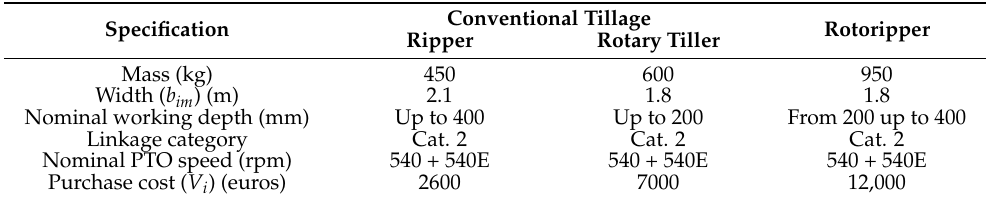
Table 1. Implement specifications claimed by the manufacturers. The purchase cost was obtained from the purchase bill for the ripper and the rotary tiller, and from the manufacturer quotation for the Rotoripper.